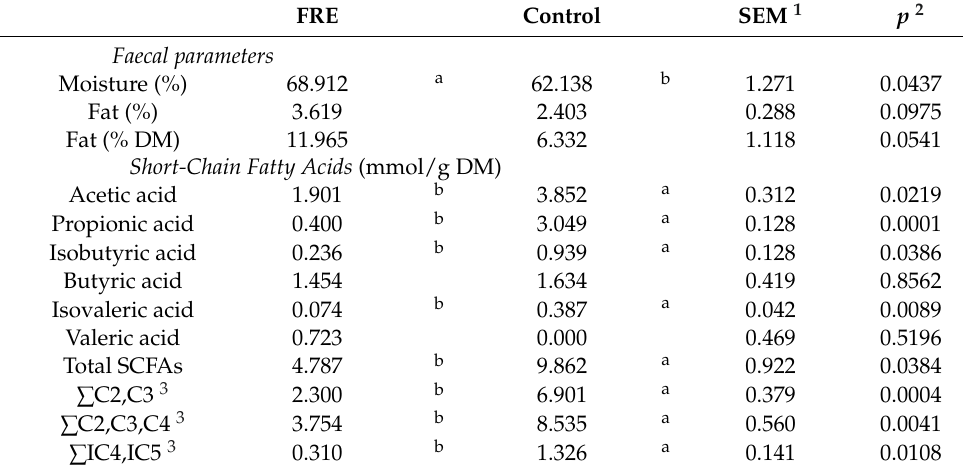
Table 3. Faecal parameters and concentration of short-chain fatty acids (SCFAs) in the faeces from the FRE (food-responsive enteropathy) and control